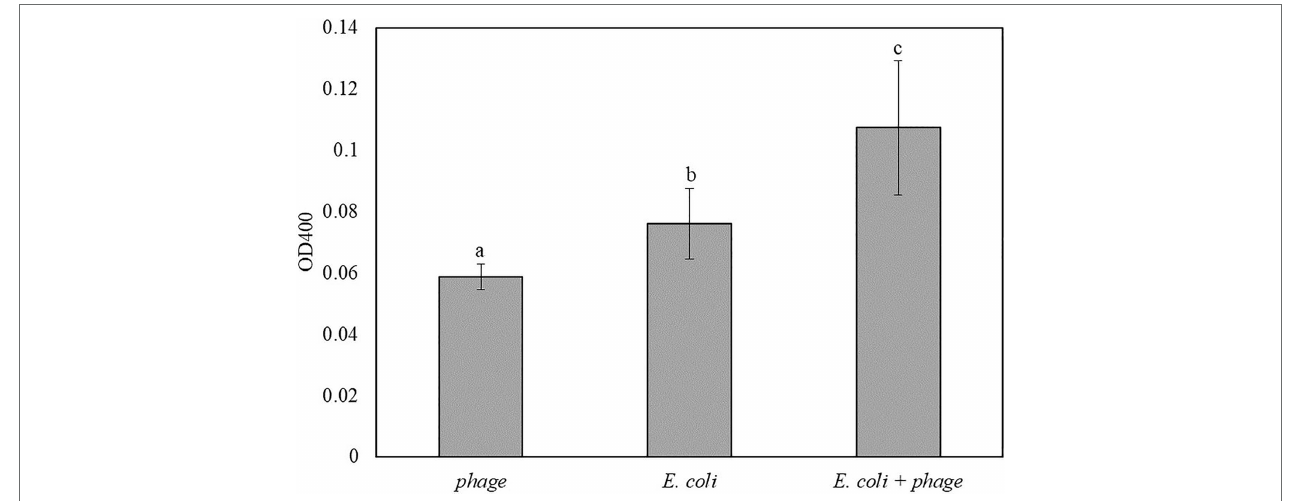
FIGURE 6 | The OD400 of 5 h-enriched 10 CFU/ml E. coli BL21 and 30 min infection with bacteriophage T7-ALP in coconut water-TSB after enzymatic reaction with p NPP for 2 h. Treatments with different letters are significantly different ( p < 0.05) error bars indicate ±standard deviation of